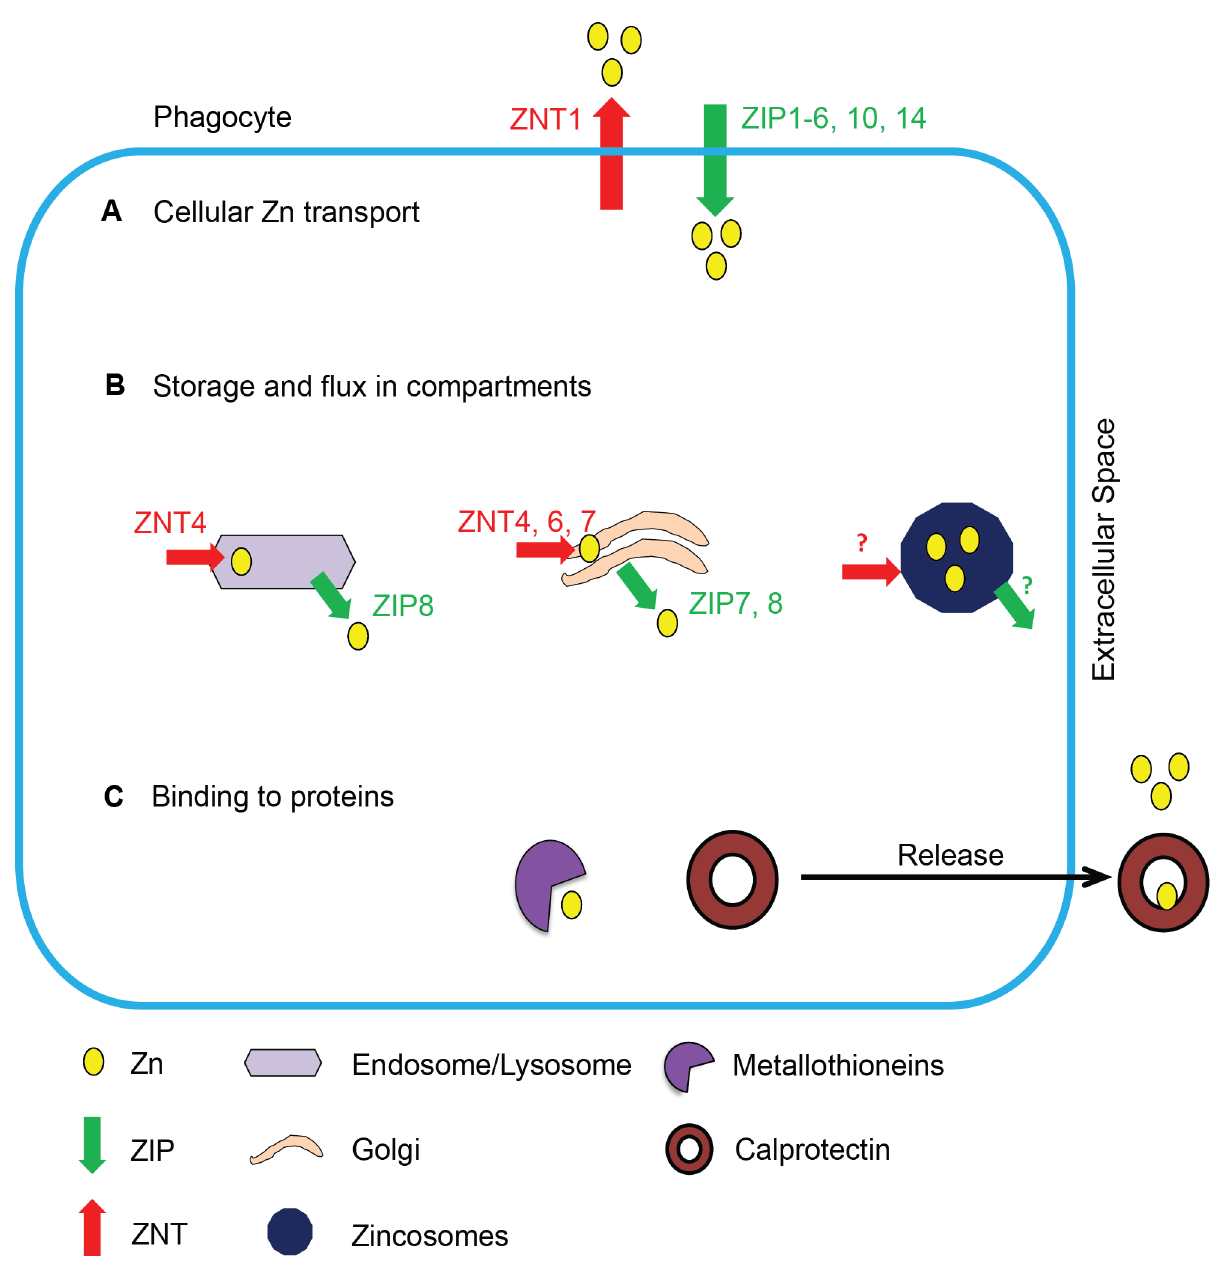
Figure 1. Schematic of Zn regulation in phagocytes. Mechanisms of Zn regulation in phagocytes, grouped into three categories: Zn 2 + transport, storage, and binding. ( A ) Zn 2 + transport across the cell membrane is mediated by ZIPs and ZNTs. ( B ) Intracellular Zn 2 + is transported into and stored in organelles such as endosomes, lysosomes, Golgi, and zincosomes by various transporters represented in the figure; the transporters that mediate Zn 2 + flux across zincosomes have not been identified. ( C ) Zn 2 + is bound and sequestered by intracellular or secreted metal binding proteins such as MTs and calprotectin.